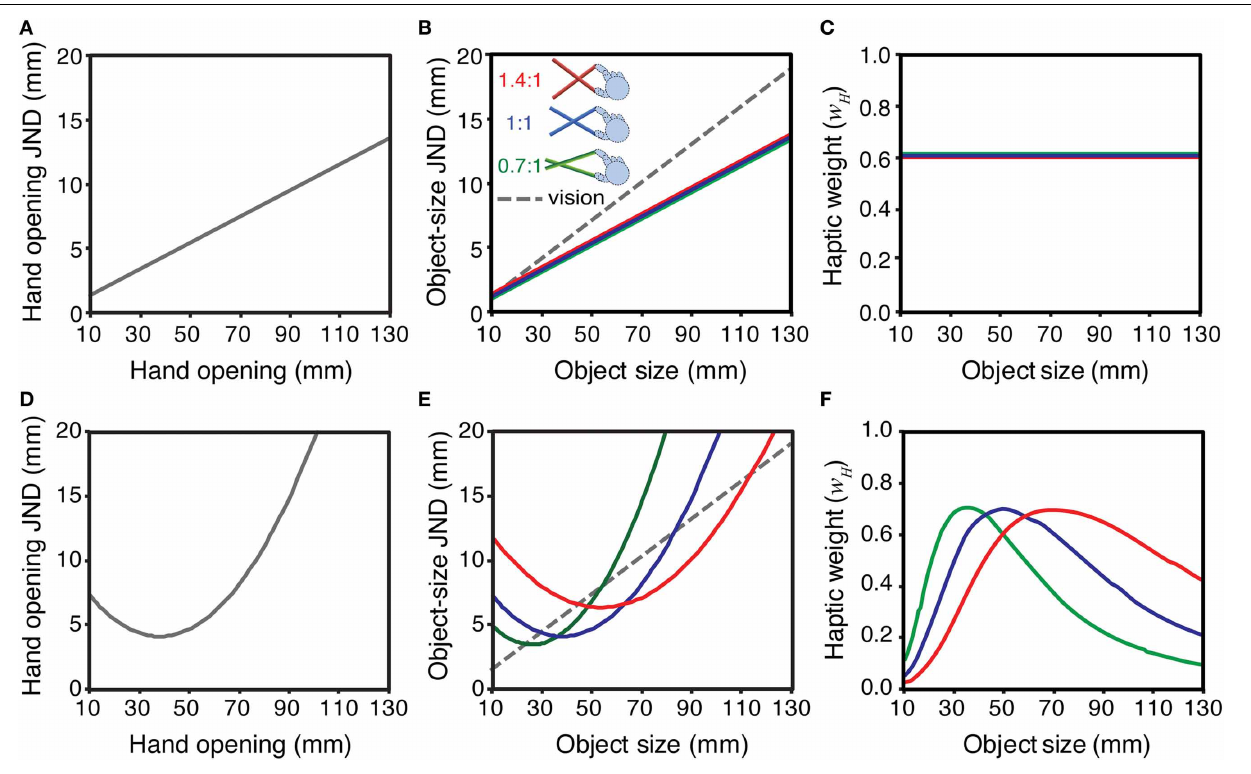
FIGURE 1 | Implications of different hypothetical hand-opening sensitivity functions for the signal weights of haptic size estimates with different tool gains. The top row shows the case where sensitivity to hand opening (JND as a function of hand opening) follows Weber’s law: (A) sensitivity to hand opening; (B) the sensitivity in A re-plotted in units of